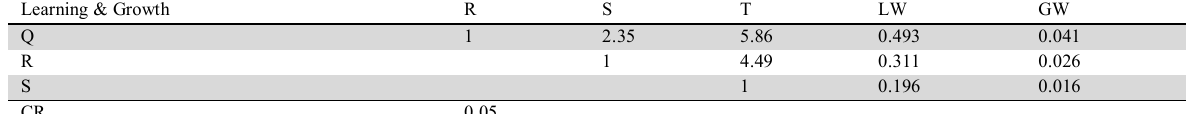
Relative importance, normalized local, global weights and consistency ratios of the Learning & growth perspective